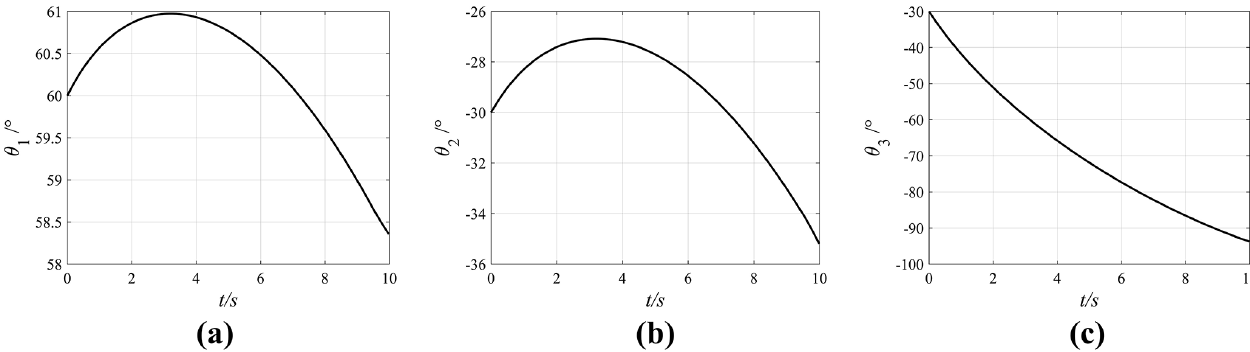
Figure 7. Motion curves of the three joints ( k 1 = 0 . 2, k 2 = 0 . 6, k 3 = 1). (a) The first joint. (b) The second joint. (c) The third